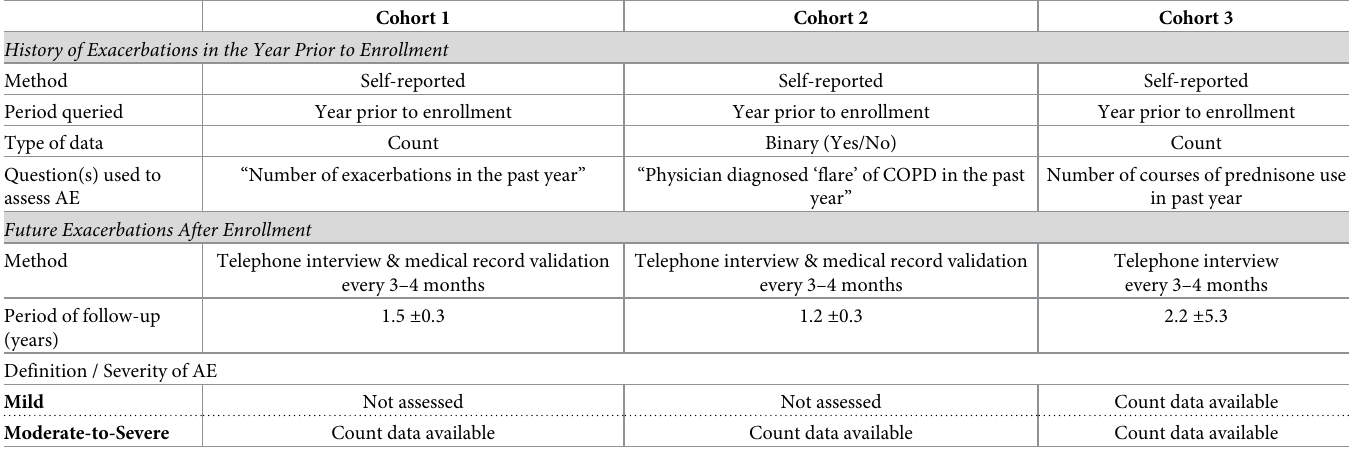
Table 2. Methods and definitions used in AE assessment by